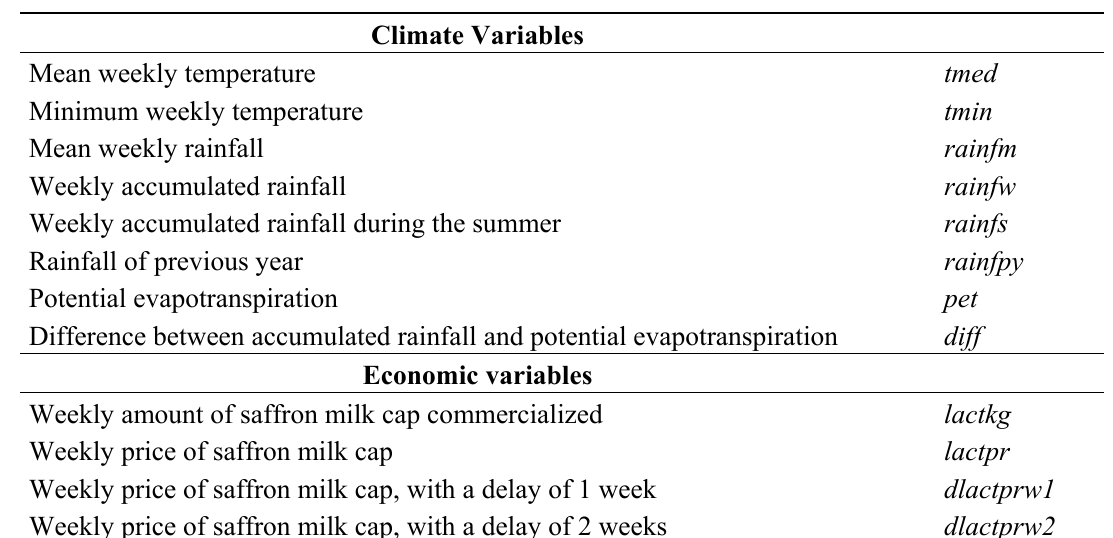
Table 1. Variables used in the statistical